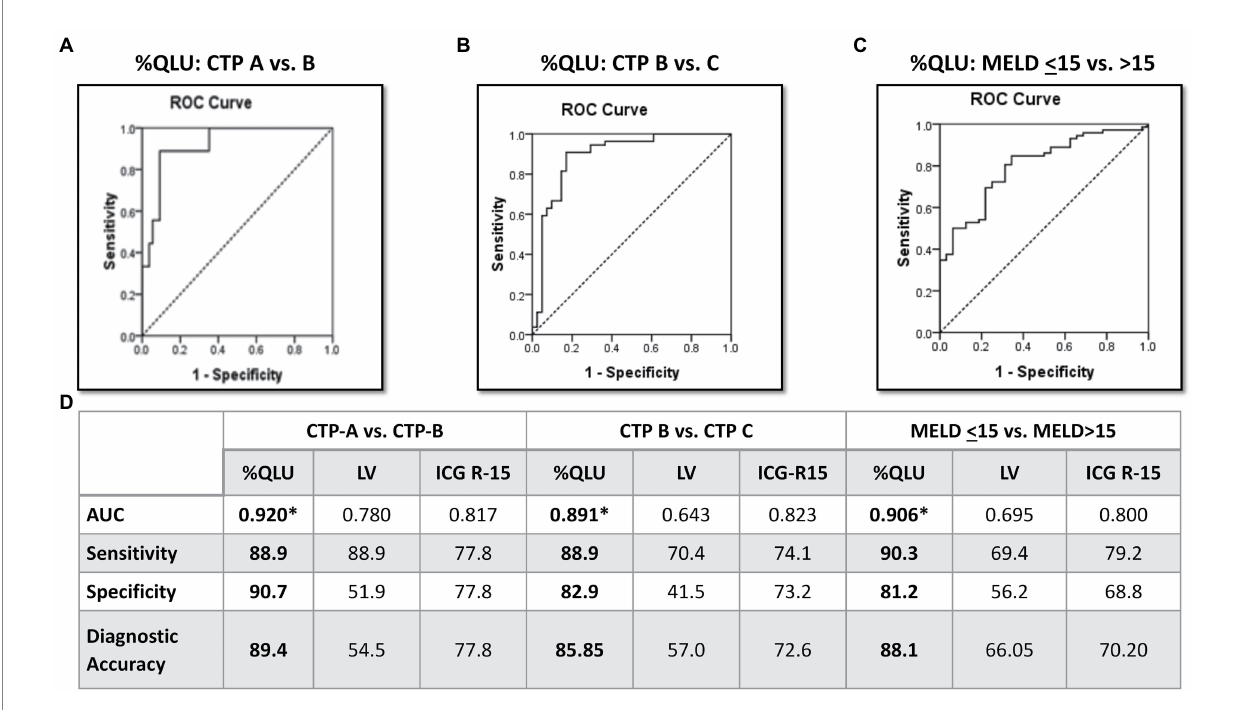
FIGURE 1 Diagnostic performance of Q-SPECT/CT and ICG-R15 for disease severity in cirrhosis Receiver operating characteristics for percentage quantitative liver uptake (%QLU) to discriminate (A) CTP-A vs. B, (B) CTP-B vs. C, and (C) MELD ≤ 15 vs. MELD>15 groups, (D) performance of %QLU, liver volume (LV), and indocyanine green retention (ICG-15) for CTP and MELD based prognostic